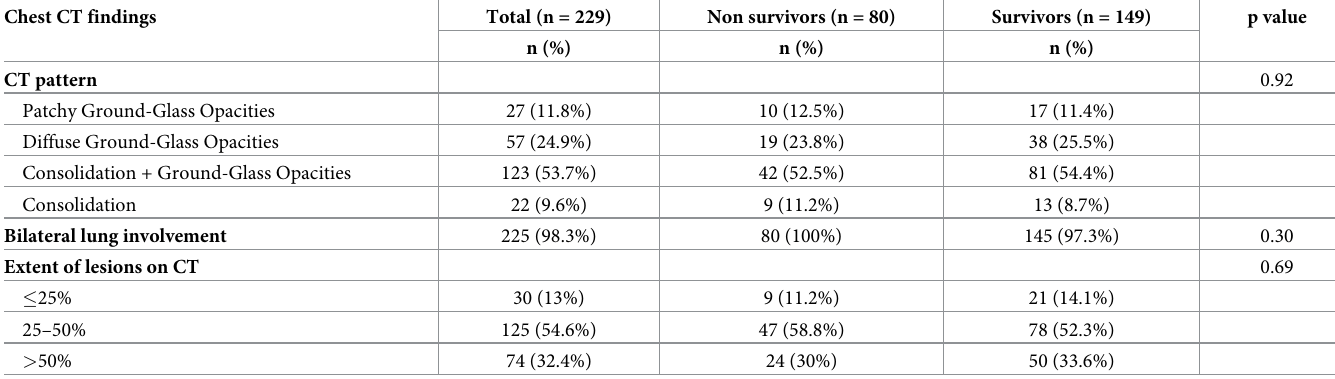
Table 3. Chest CT findings in survived and non-survived